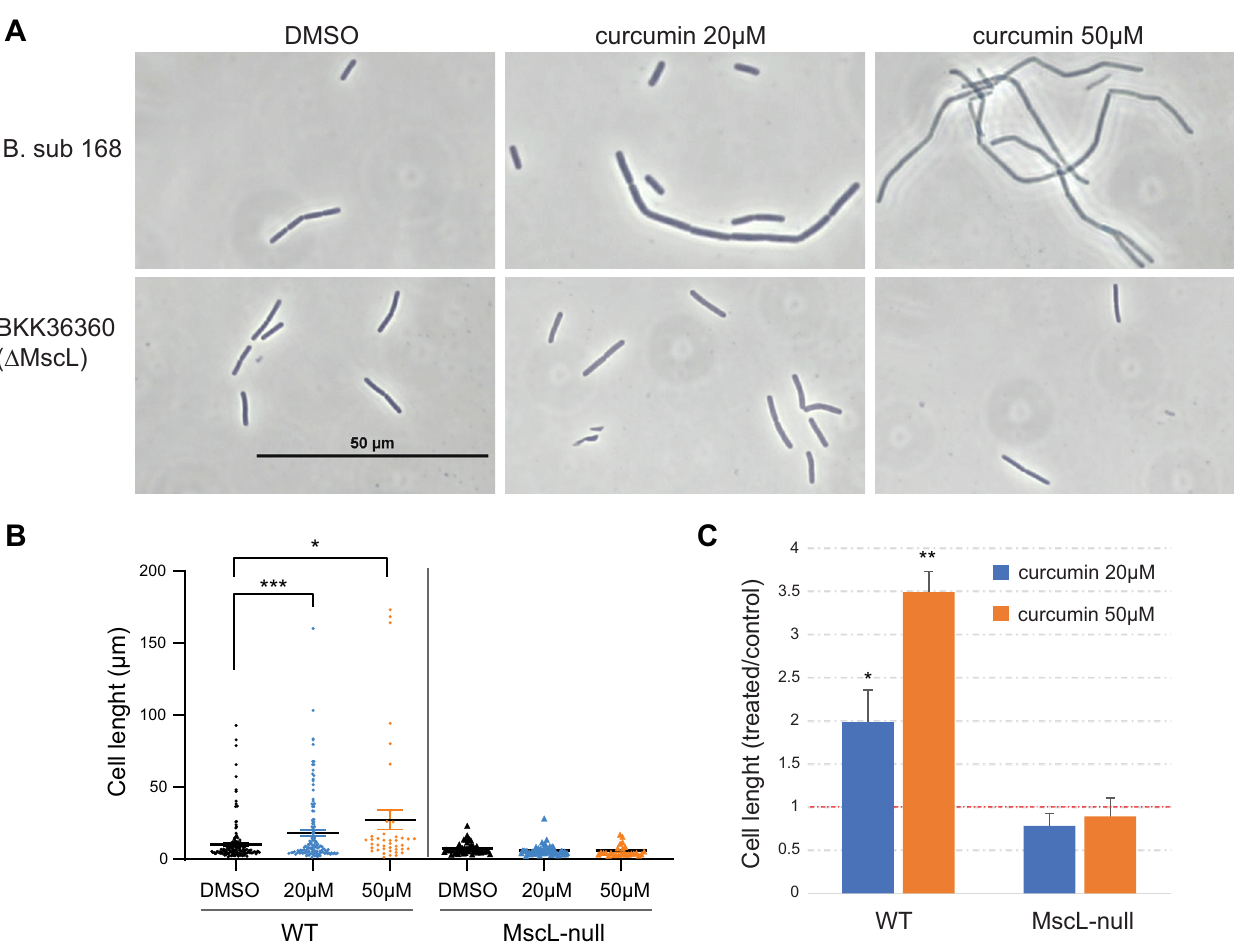
Fig 7. MscL is required for the inhibition of septation by curcumin. A. Shown are representative pictures of cultures of the B sub strain 168 (WT) and its MscL-null derivative, grown under different curcumin concentrations. B. The graph shows the length of the cells measured for both strains, under different treatments. ��� p < 0.005, � p < 0.02 (Unpaired t test with Welch’s correction). C. A comparison of the change in cell length after curcumin treatment, presented as the ratio between treated and untreated cells, for WT and MscL-null strains. � p < 0.05 �� p < 0.005 t-test, unpaired.